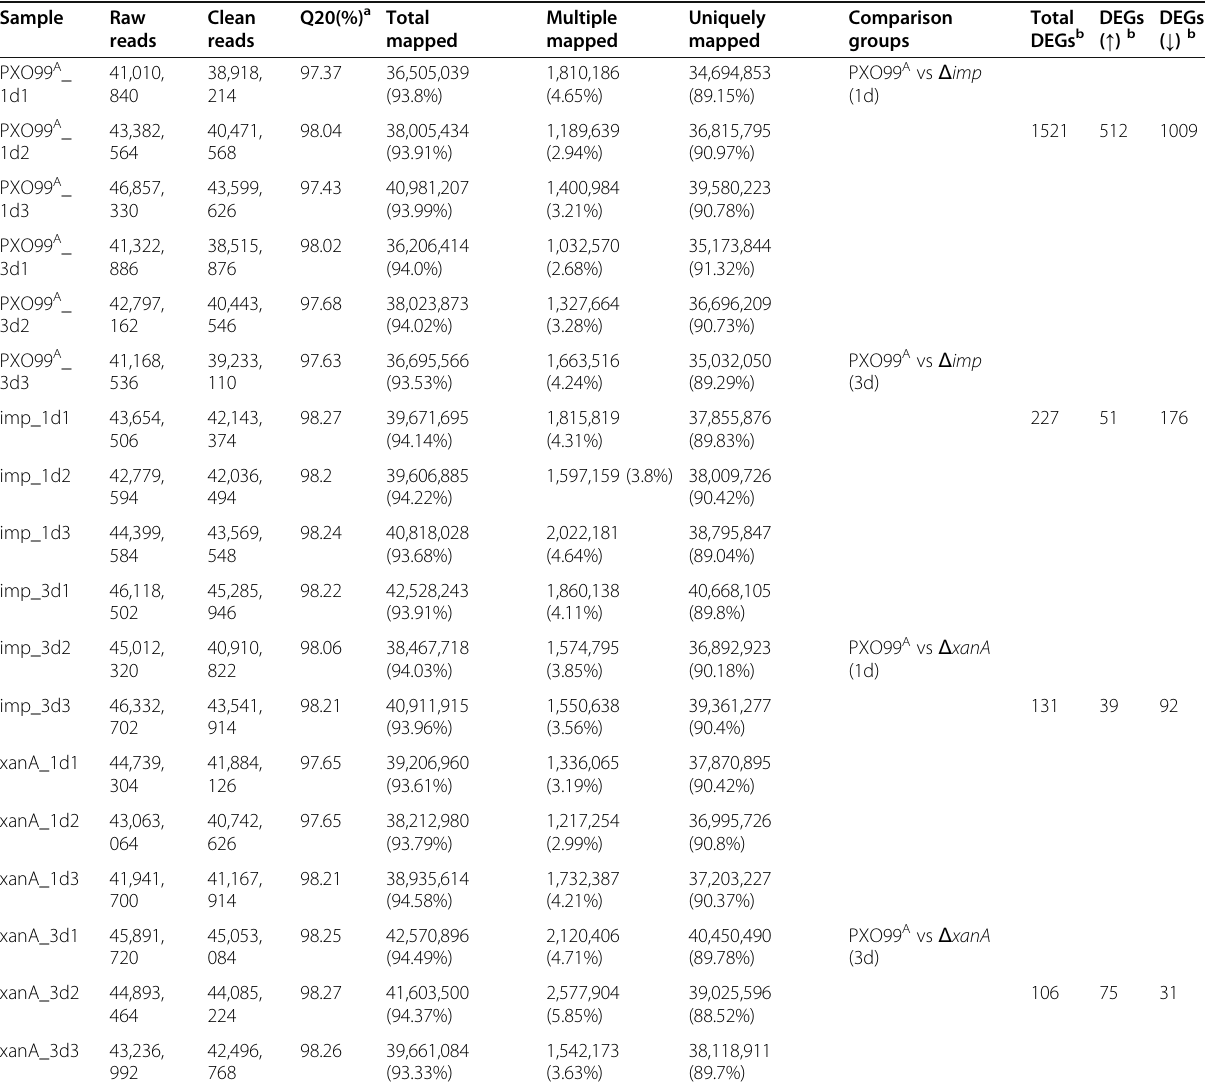
Table 2 Summary of transcriptome sequencing data produced by Illumina sequencing Sample Raw